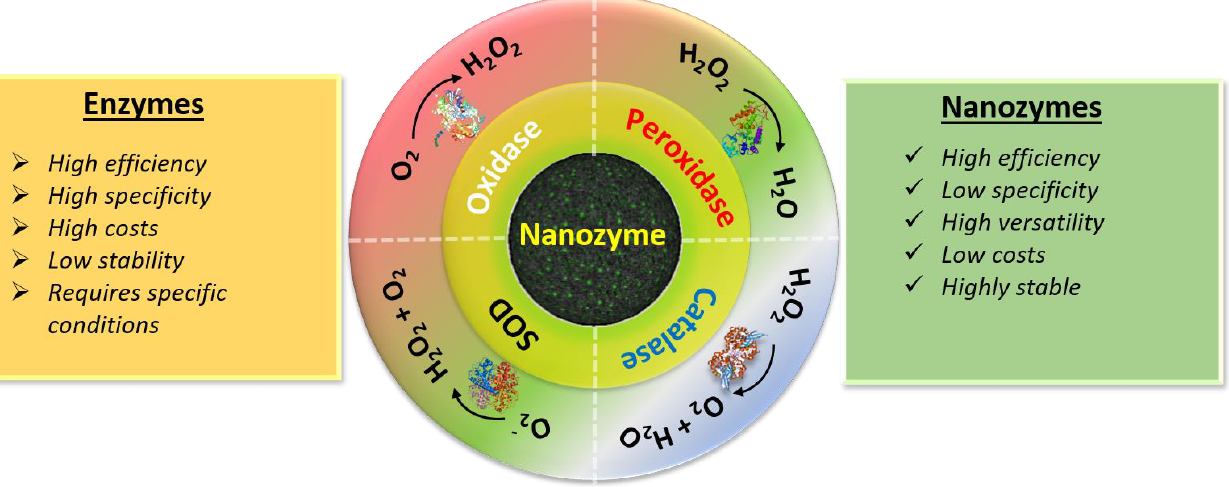
Figure 1. The properties of various nanozymes and their advantages over enzymes.